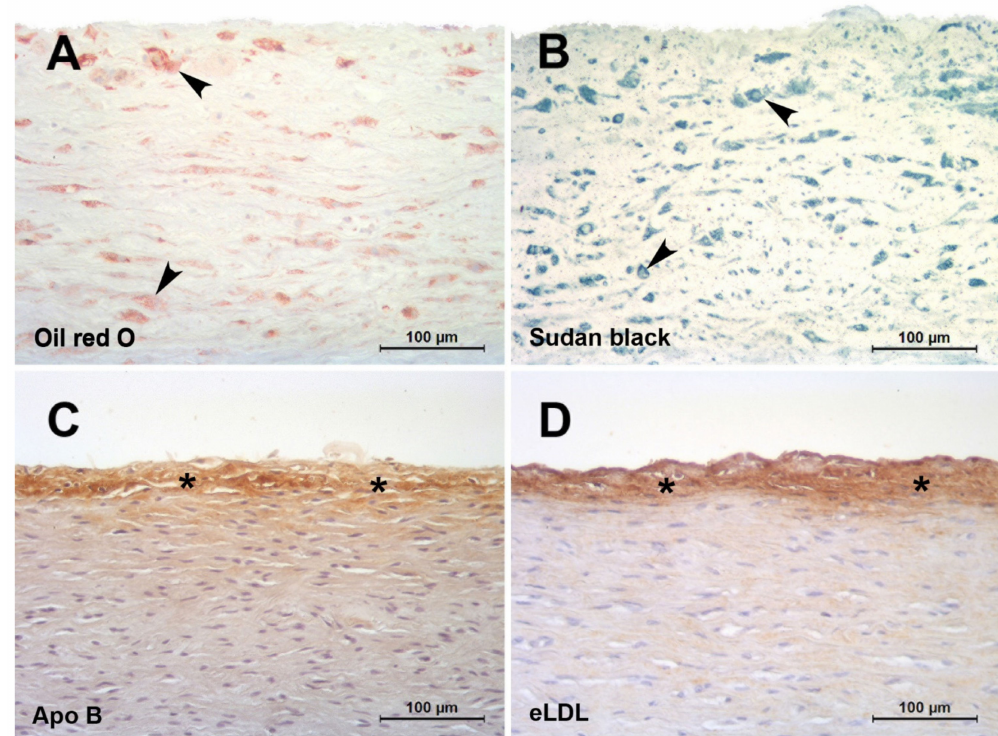
Figure 1. Red herrings and hallmarks of the initial atherosclerotic lesion. ( A , B ): Initial human aortic atherosclerotic lesions fixed in 4% formaldehyde and infiltrated and embedded in the water soluble plastic Technovit 7100 based on HEMA and GMA [53,54]. The use of alcohol containing fluids was strictly avoided. Staining with lipid-soluble dyes such as oil red O ( A ) or Sudan black ( B ) do not detect extracellular but only intracellular lipids (arrowheads). ( C , D ): Initial human aortic atherosclerotic lesions fixed in 4 % formaldehyde and infiltrated and embedded in paraffin. Staining with a polyclonal antibody against apolipoprotein B ( C ) [16] or AIL-3 (IgG 1 ) against eLDL ( D ) [23]. Even after lipid extraction by the dehydration process, extensive extracellular epitopes (asterisks) can be detected in spite of the almost complete absence of